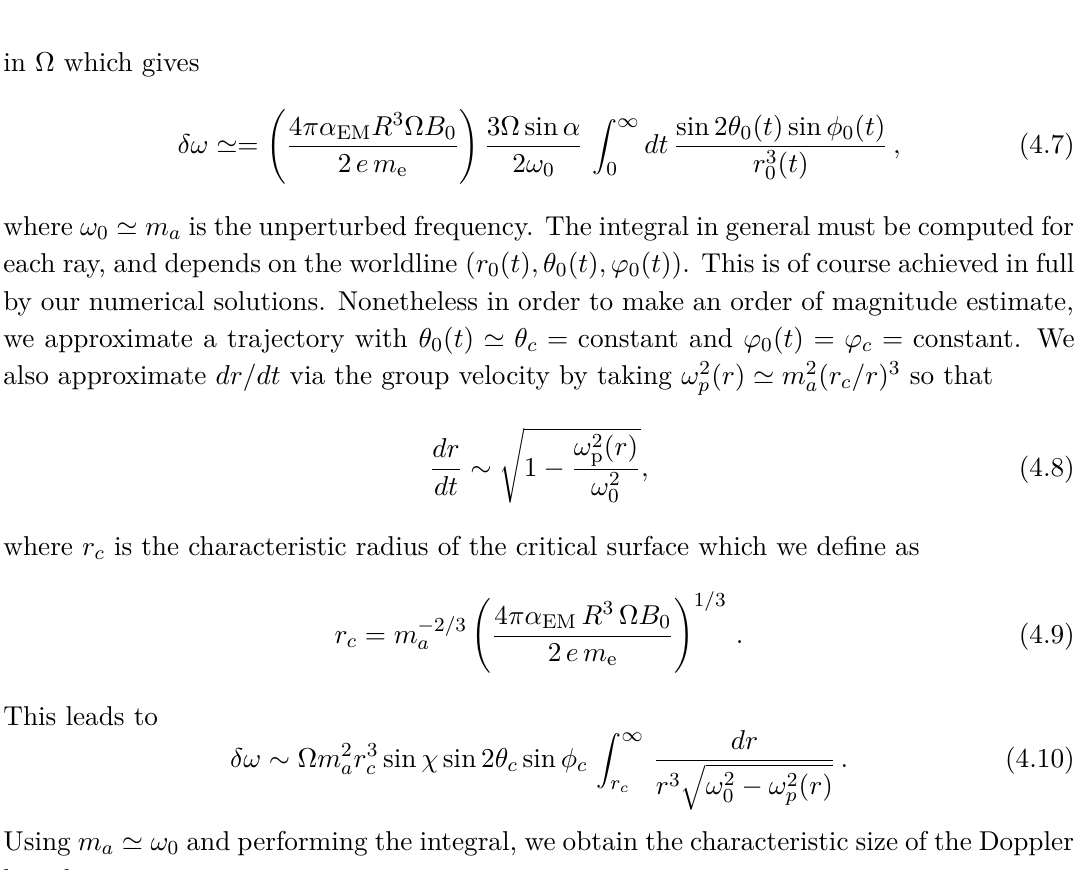
Figure 7 . Time-dependence of line shape. We display the instantaneous line shape for m a = 0 . 5 µ eV at each point in the pulse